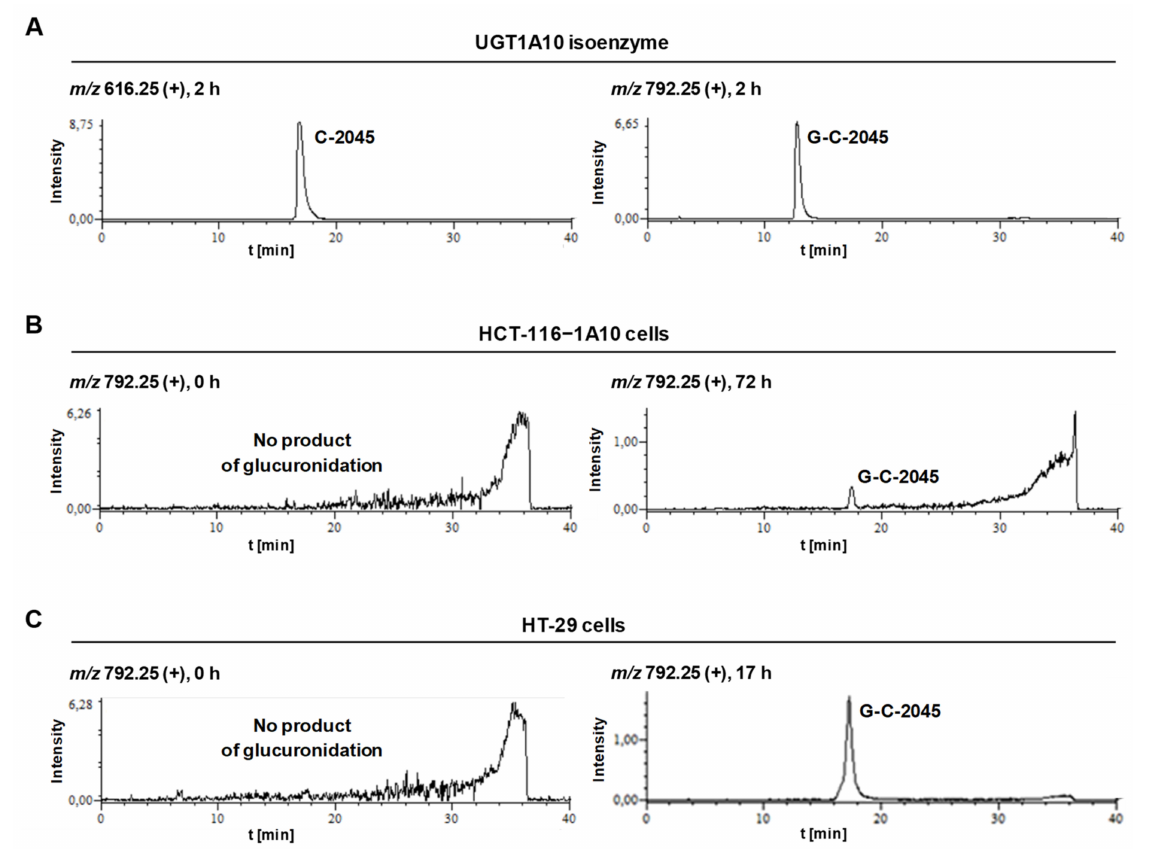
Figure 10. Representative extracted ion chromatograms of HPLC-MS analysis acquired 616.25 m / z for C-2045 and 792.25 m / z for the sample obtained by incubation of C-2045 with ( A ) isoenzyme UGT1A10, ( B ) the cells HCT-116-1A10 and ( C ) the cells HT-29 after positive